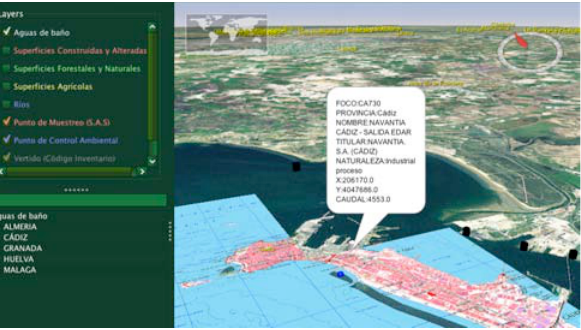
Figure 10 Beaches of Andalucía Figure 12 A mulidimensioal data